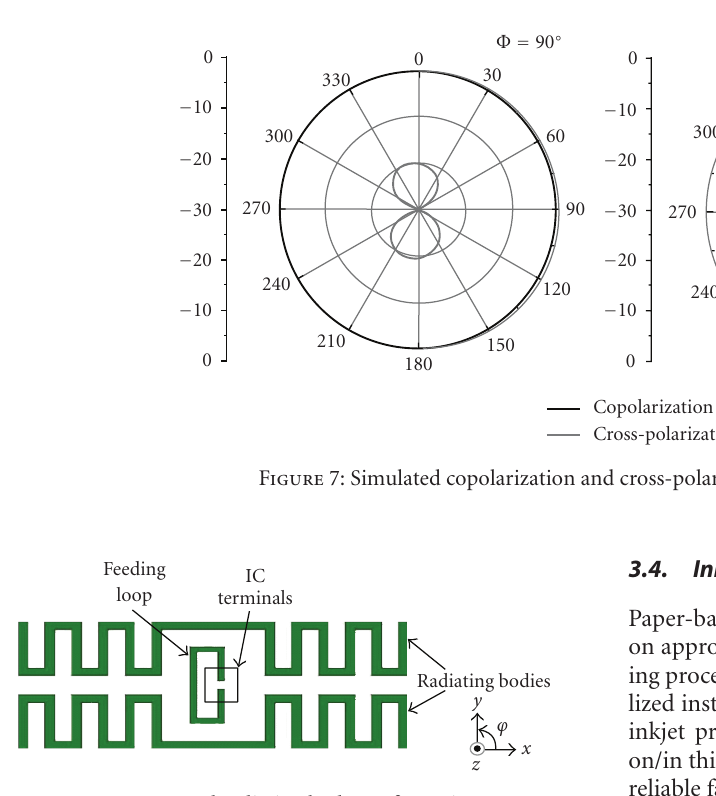
Figure 8: Dual radiating body